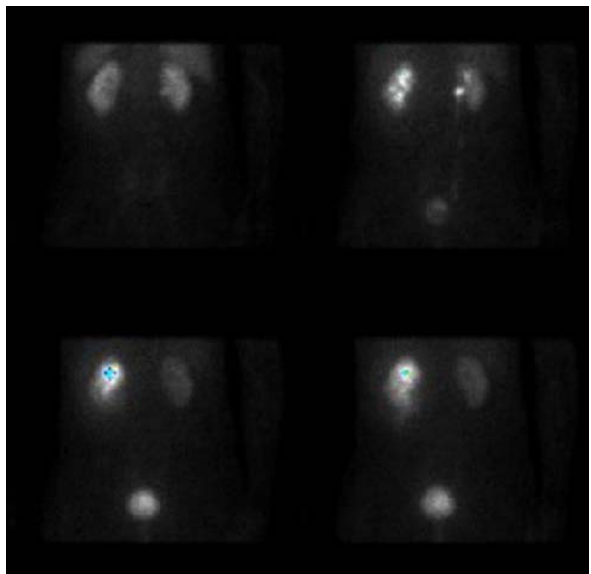
FIGURE 5. 99mTc-DTPA renal scintigraphy (4/17/06). Normal right kidney. Focal tracer accumulation in upper left pole and urine extravasation through left superior fornix and perirrenal